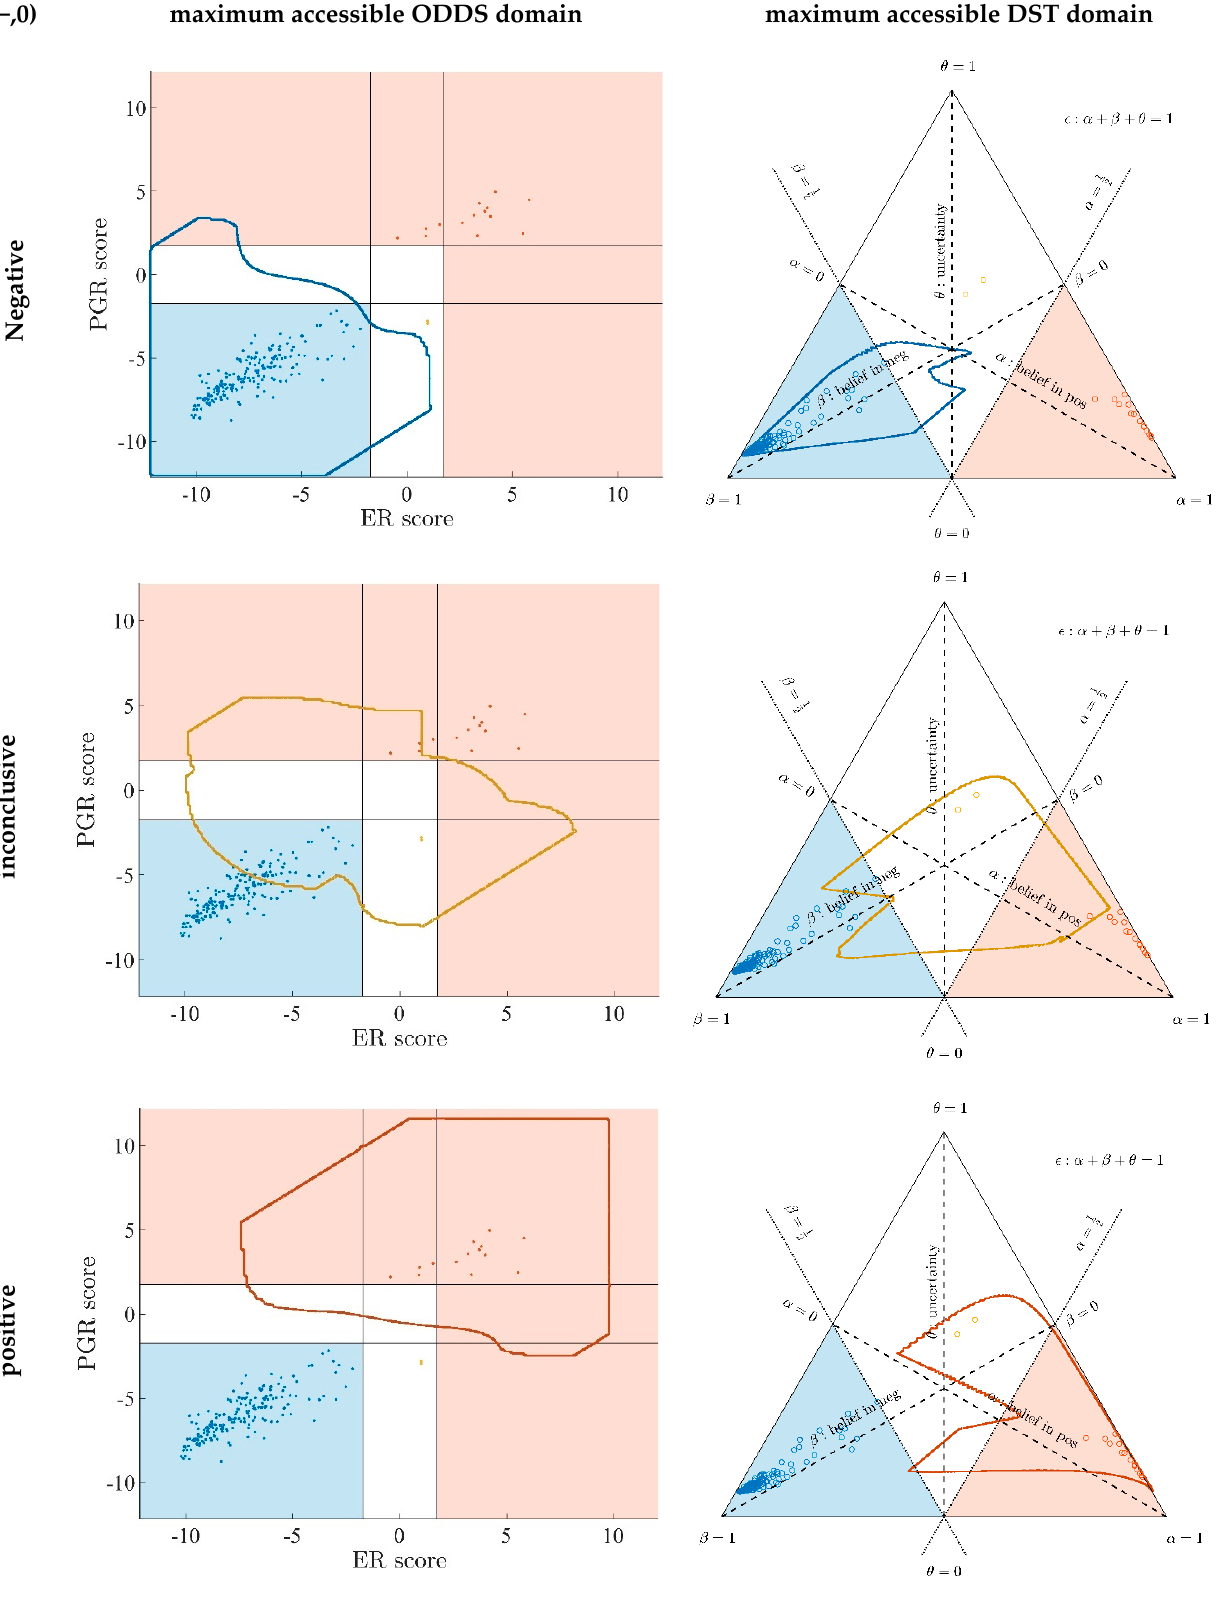
Figure A7. Real sample data within maximum accessible domains for the IHC case = ( − ,0). For general features of display see caption to Figure A3.